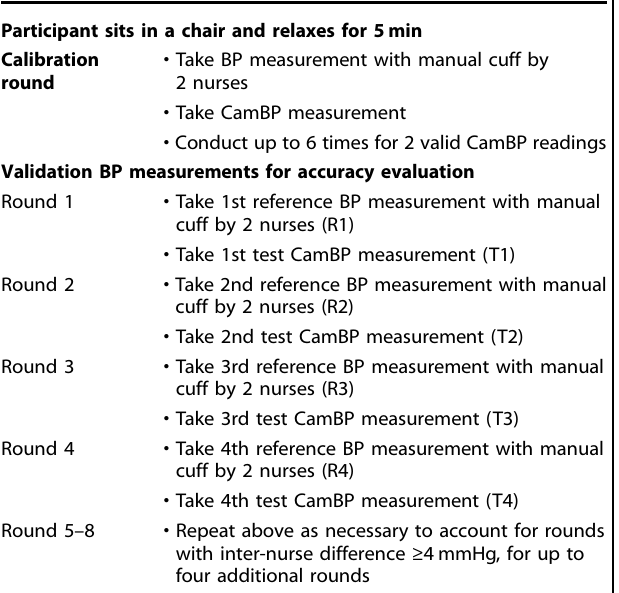
Validation BP measurements for accuracy evaluation